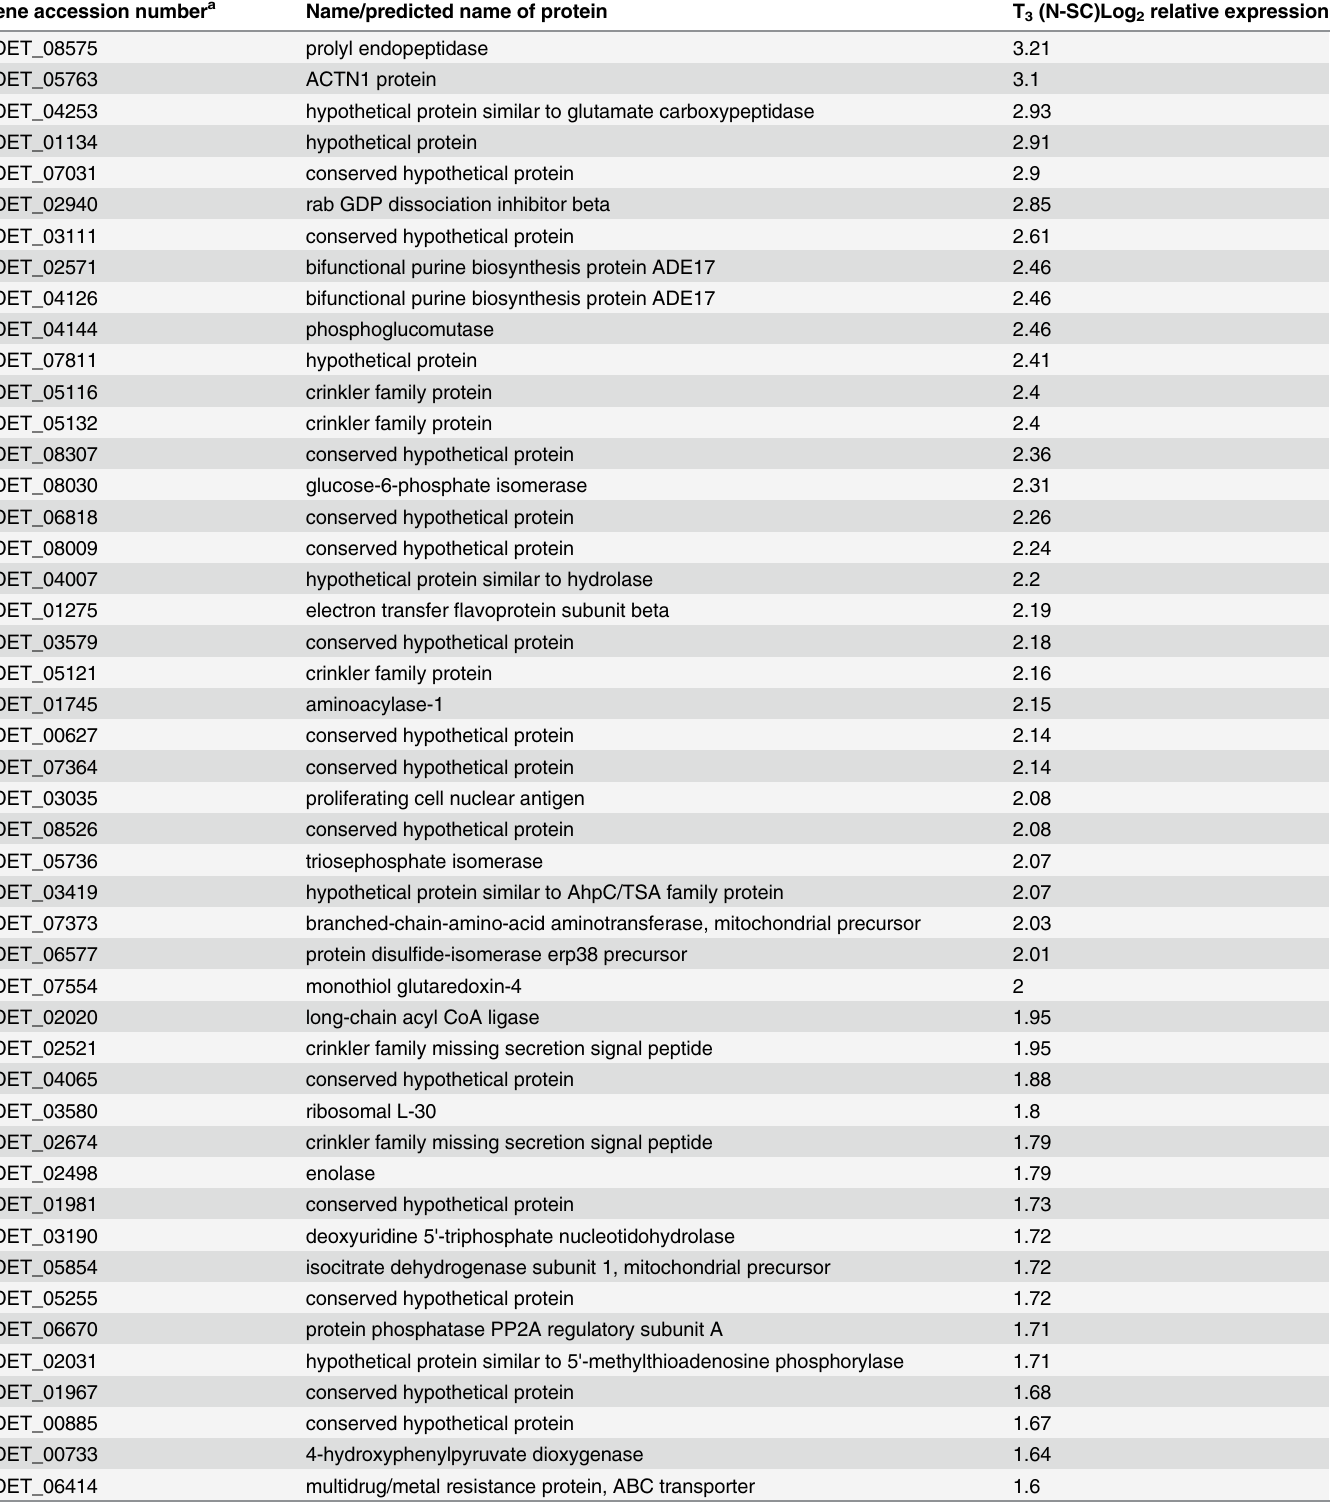
Table 1. List of proteins that showed more than 2-fold increase in Bd exposed to T 3 . Gene accession number